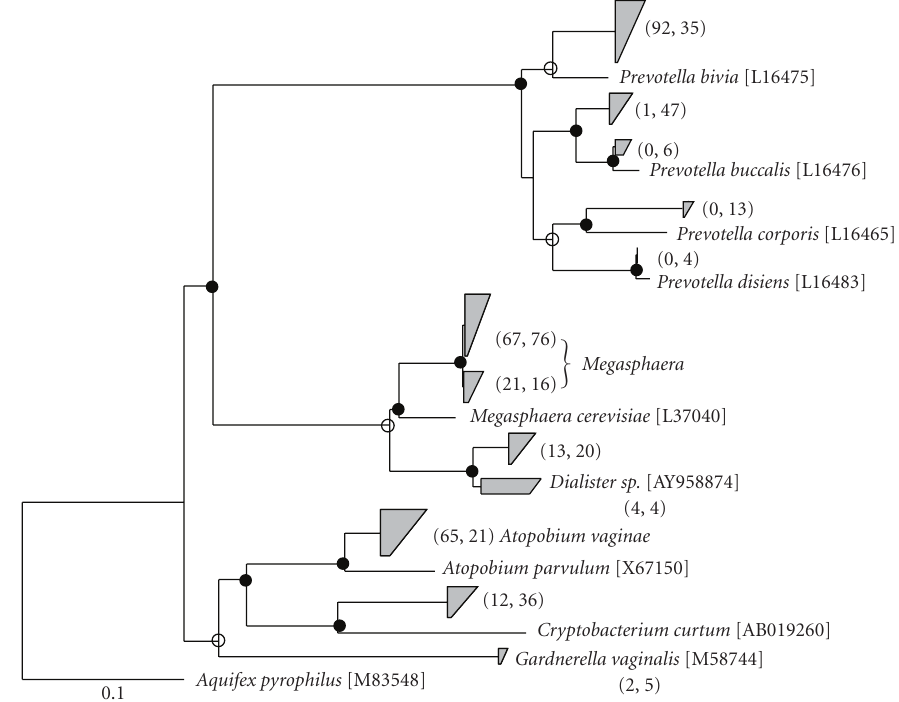
Figure 3: Neighbor joining-based phylogeny of 16S rRNA gene clones related to bacterial genera consistently present in participants with bacterial vaginosis. Closely related clones were condensed into trapezia with numbers in parentheses representing, for each group, the number of clones obtained from participant 6 (left) and participant 7 (right). The phylogeny is based on 503 unambiguously aligned nucleotides. Branch points with > 75% conservation are represented by a closed circle. Genbank accession numbers for reference species are shown in brackets. A 16S rRNA gene from Aquifex pyrophilus was used as the outgroup. Scale bar represents 0.1 change per